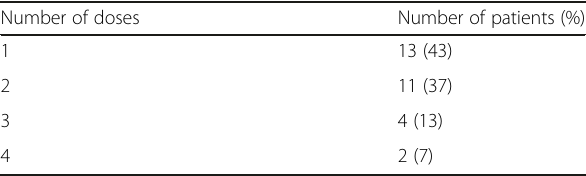
Table 6 Distribution of treated patients ( n = 30) according to the number of antivenom doses Number of doses Number of patients (%)